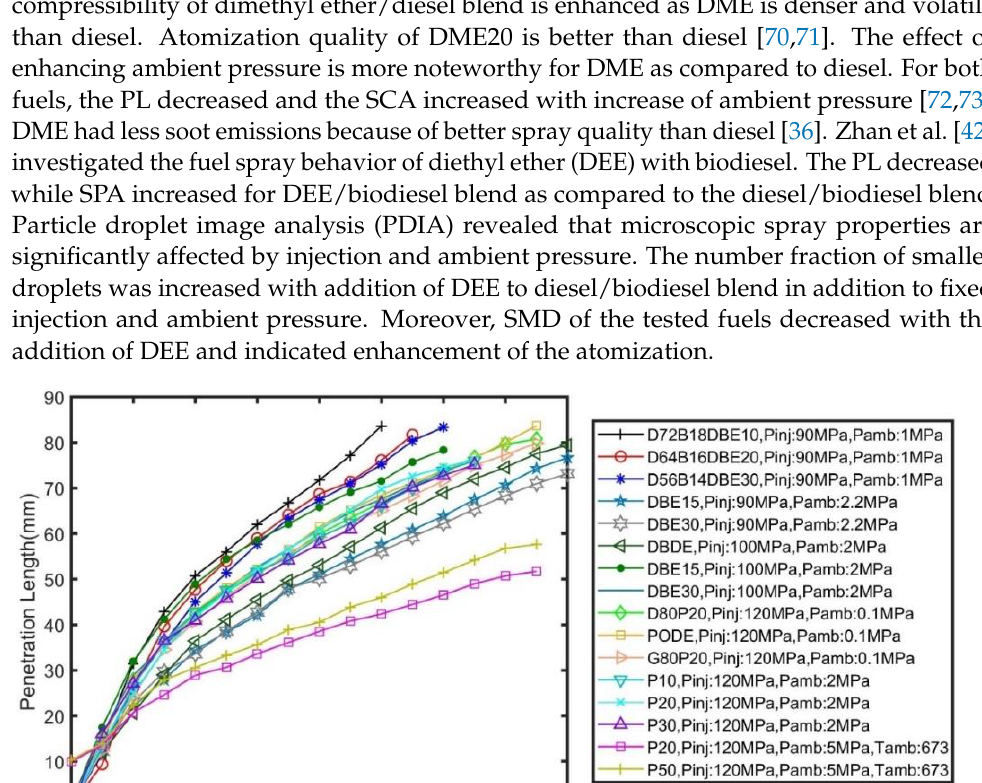
Figure 8. Spray cone angle for various ether-based additives (such as DBE, PODE) with diesel at different injection & ambient pressures [30,74 – 77]. Figure 9. SMD for various ether-based additives (such as DBE, PODE) with diesel at different injec- tion & ambient pressures [30,42,74,75,78].